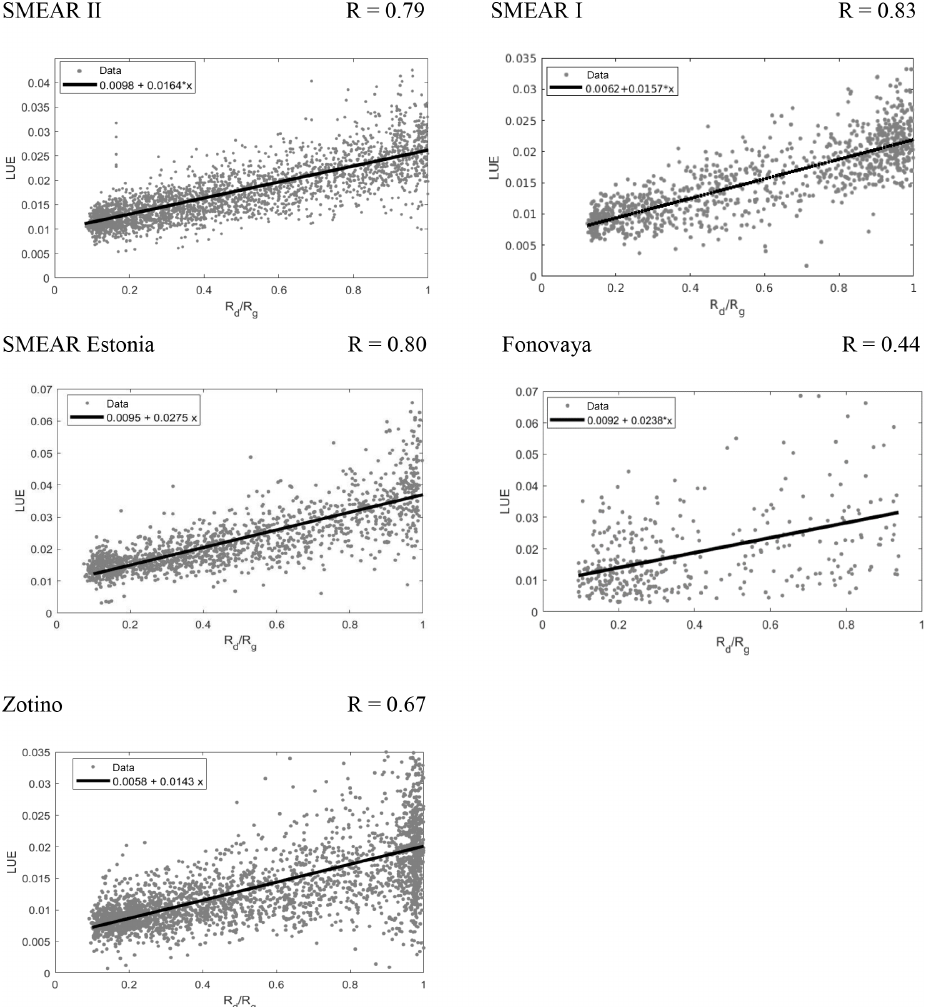
Figure 6. Light use efficiency (LUE) as a function of the diffuse fraction of global irradiance ( R d /R g ). All dependences are statistically significant ( p < 0 .